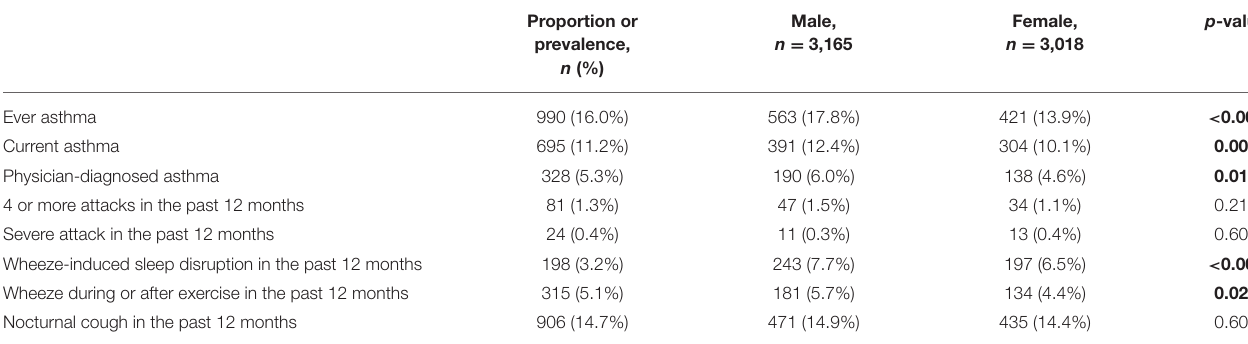
TABLE 1 | Prevalence of asthma in the study ( n =